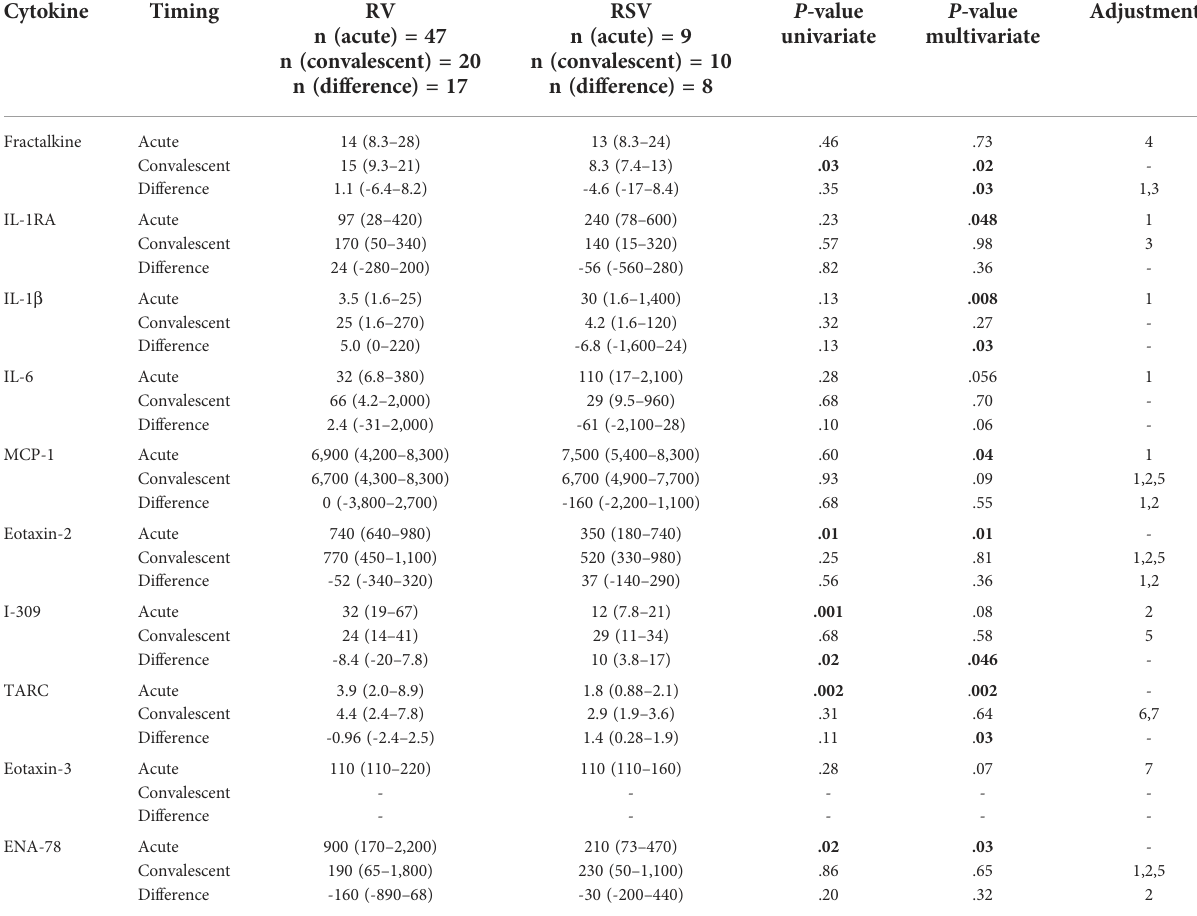
TABLE 2 Differences in cytokine expression levels at study entry and the convalescent phase. Cytokine